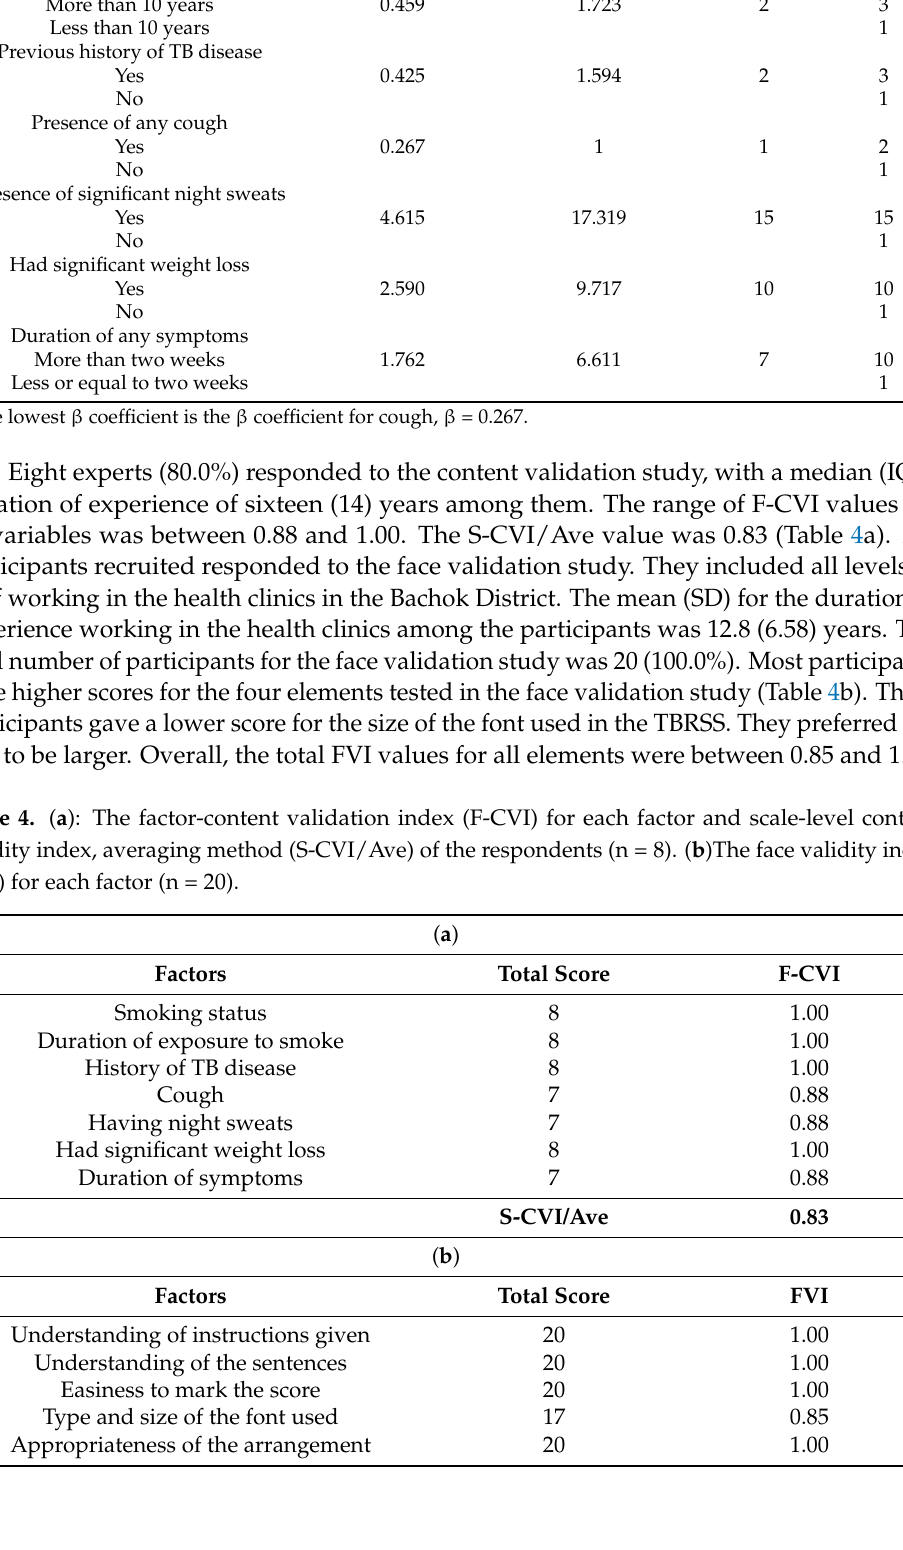
Table 3. To determine the score for each of the variables. Variables β -Coefficient